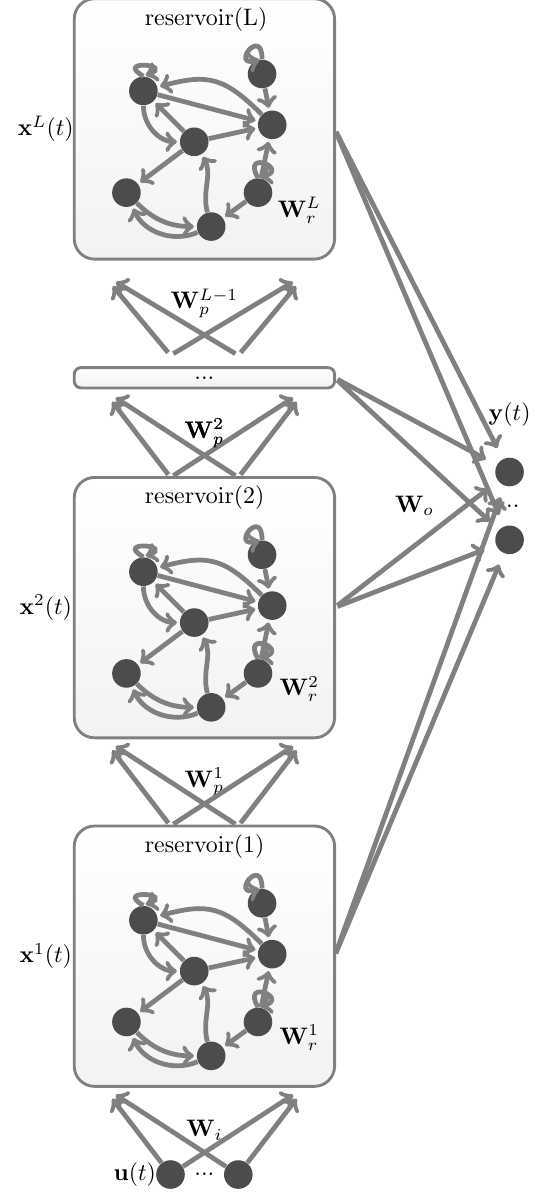
Figure 2. Structure of